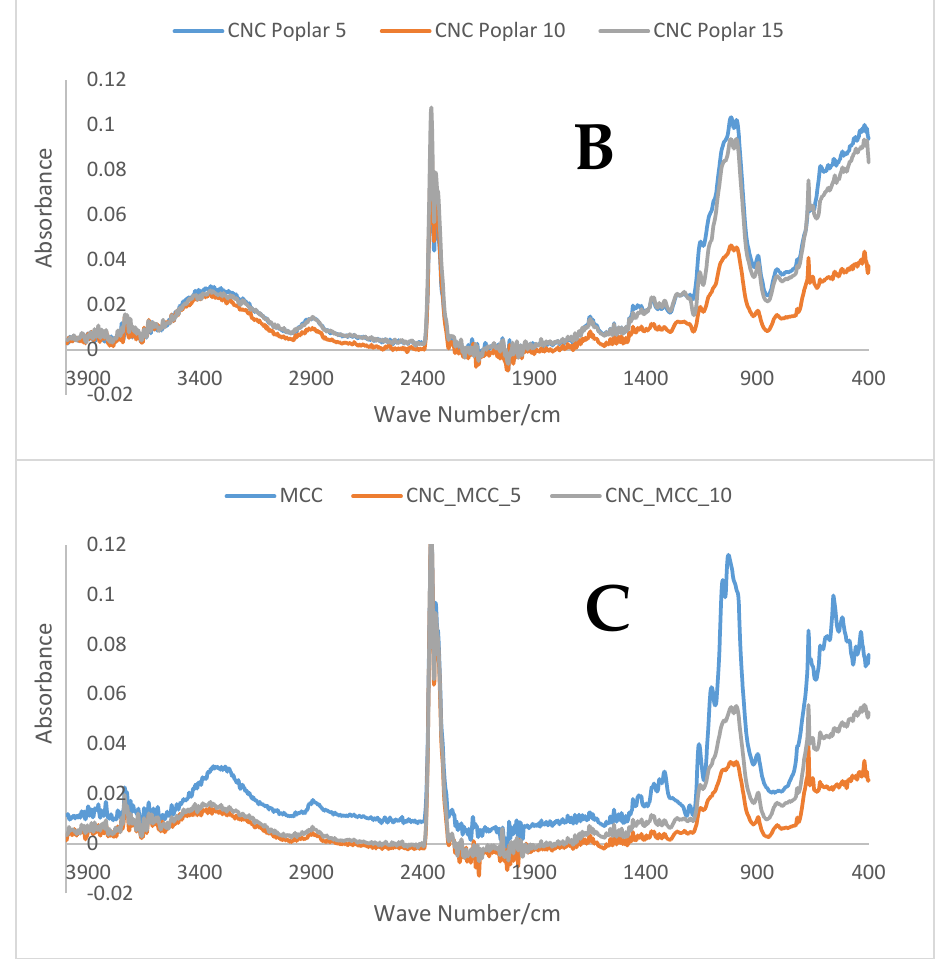
Figure 3. FTIR spectral investigations of ( A ) Native, pulped, and bleached poplar, ( B ) Cellulose nanocrystals (CNC) sourced from poplar after 4, 10, and 15 min of hydrolysis, and ( C ) microcrystalline cellulose (MCC) and CNC sourced from MCC after 5 and 10 min of hydrolysis.